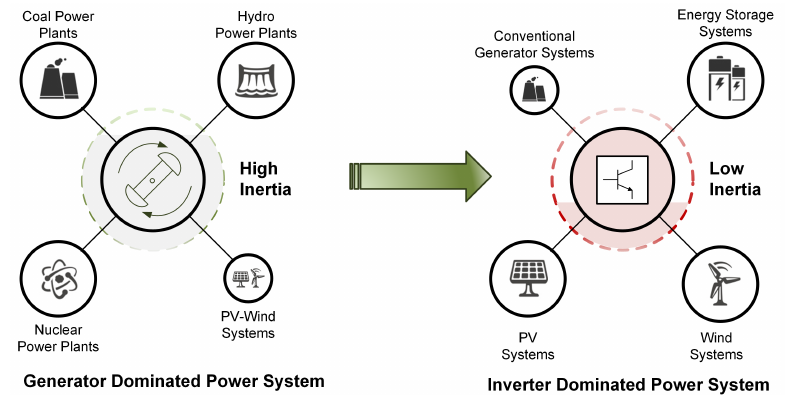
Figure 1. Evolution towards an inverter dominated power system.